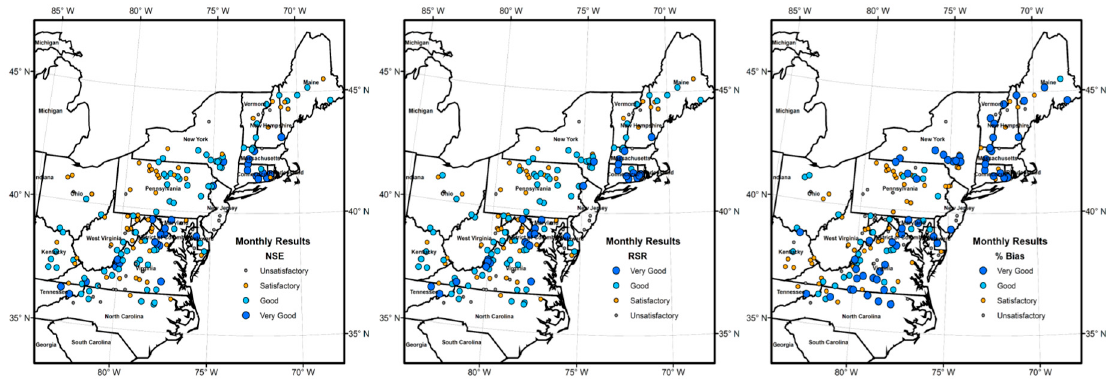
Figure 5. Nash Sutcliffe efficiency, root mean square error (RMSE) - observations standard deviation ratio, and percentage bias monthly streamflow for the period of 1980–2015, according to Table 4 from Reference [40].